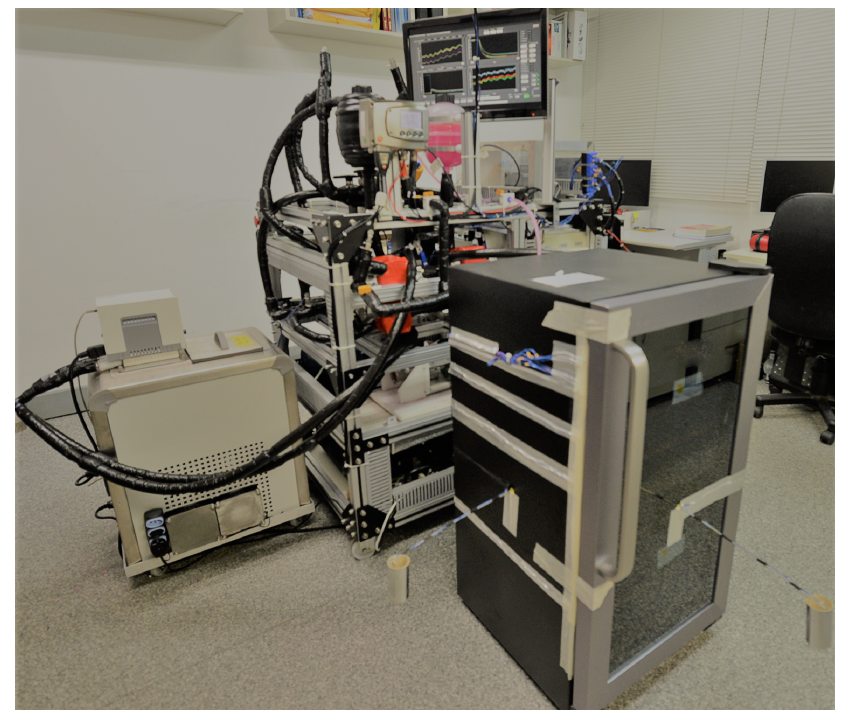
Figure 2. Retrofitted wine cooler cabinet connected to the experimental